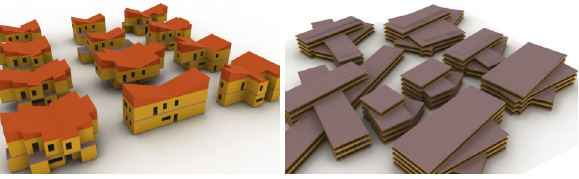
Figure 18: Populations of freeform